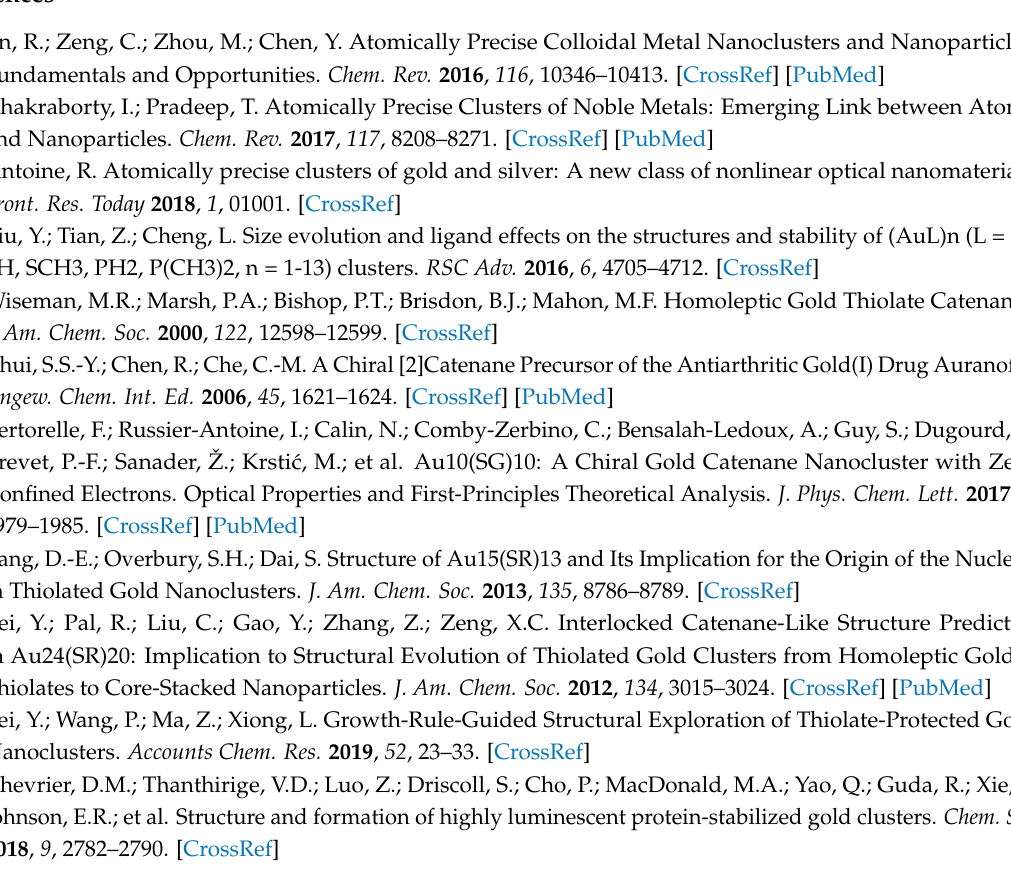
Figure S1: Chemical structure of thioglycolic acid (TGA). Figure S2: Collision-induced dissociation spectra of (Au 10 (TGA) 10 ) 3 − . Figure S3: ATDs recorded for two charge states of Au 10 (TGA) 10 in negative mode. Figure S4: ATDs recorded for two charge states of Au 10 (TGA) 10 compared to the fick law. Figure S5: DFT structures obtained for [Au 10 (TGA) 10 − 2H] 2 −